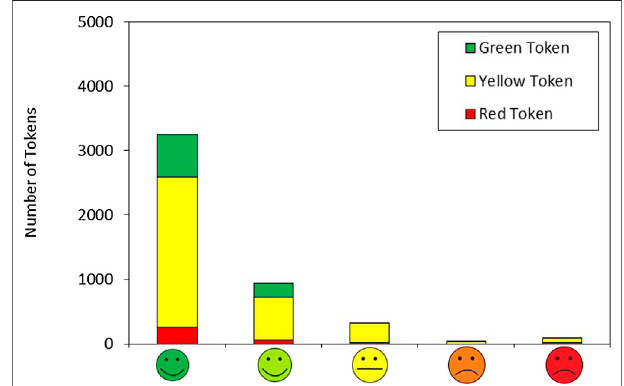
FIGURE 7 | Bar chart of participant feelings on hydrogen following The HydrogenBike demonstration.Therewere fi vedifferenttubestoplaceatoken at the end of demonstration, each marked with an emoticon. The color of the bar denotes the color of the token the participant was issued at the start of the